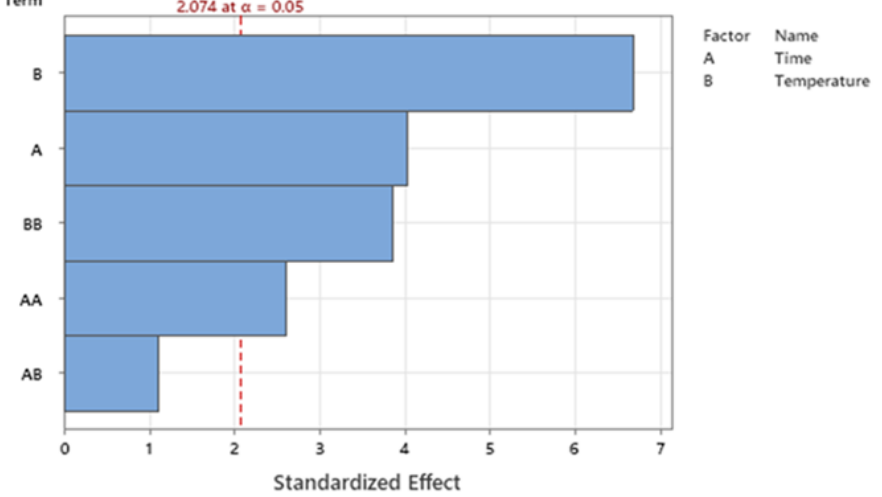
Figure 1. Pareto chart of significative and not significative parameters analyzed, i.e., extraction time (A) and temperature (B).